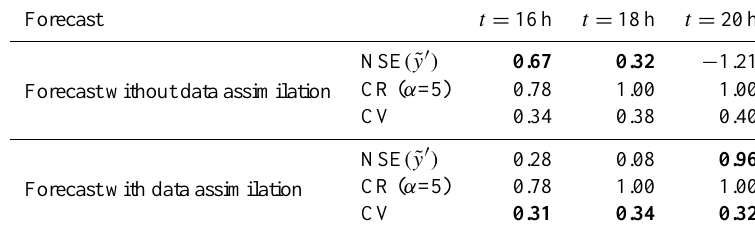
Table 4. Results of the validation measures for the December 2003 flood event. Forecast t = 16h Forecast without data assimilation